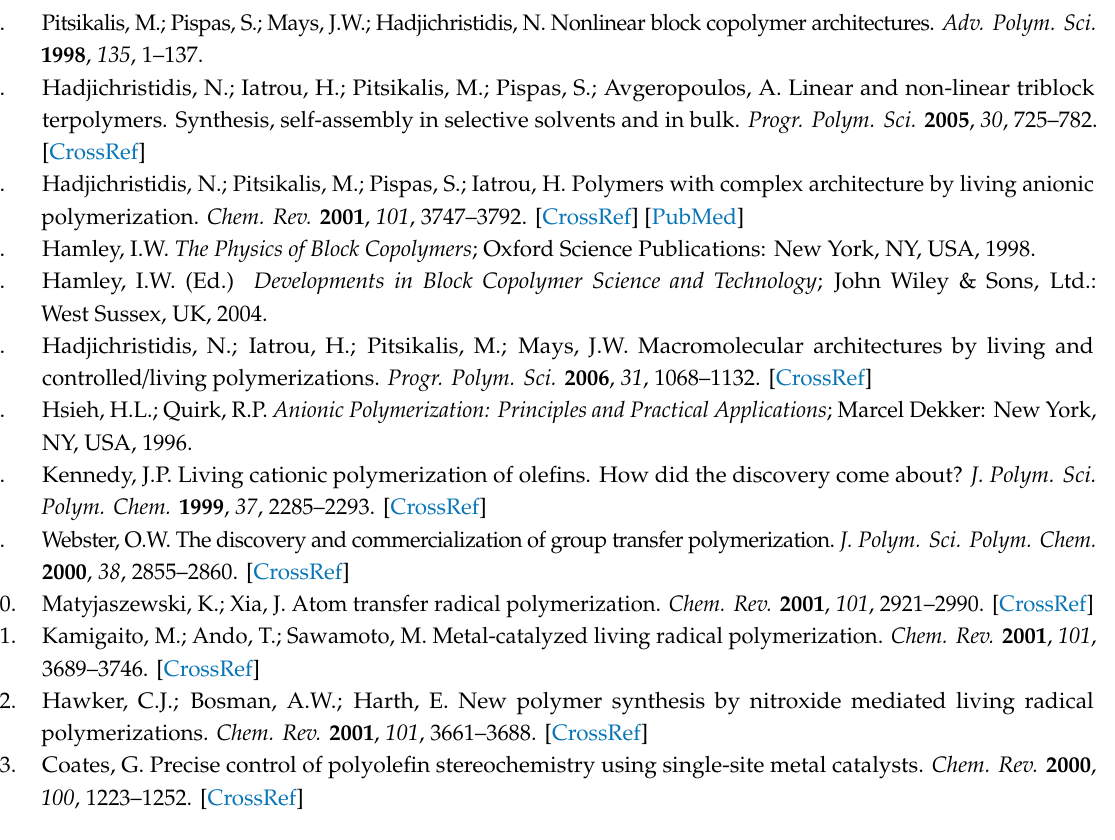
Figure S1: 1H NMR spectrum of sample SDBC in CDCl3 at 25 ◦ C; Figure S2: 1H NMR spectrum of sample BDBC in CDCl3 at 25 ◦ C; Figure S3: 1H NMR spectrum of sample B-(PLLA-b-PCL-b-PLLA) in CDCl3 at 25 ◦ C; Figure S4: DTG plots of the single macromonomers; Figure S5: DTG plots for the double macromonomer NBE-(PLLA)2 #2; Figure S6: DTG plots for the double macromonomer NBE-(PCL)2 #2; Figure S7: DTG plot for the sample DB-PCL; Figure S8: DTG plot for the sample SDBC; Figure S9. DTG plot of the sample DB-PLLA; Figure S10: DSC graph for the double macromonomer NBE-(PCL)2; Figure S11: DSC graph for the double brush DB-PCL; Figure S12: DSC graph for the double macromonomer